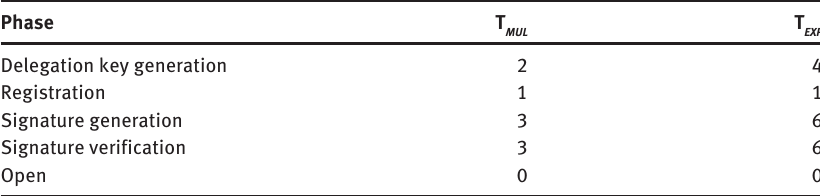
Table 2. Time complexity of the proposed scheme over Ref.